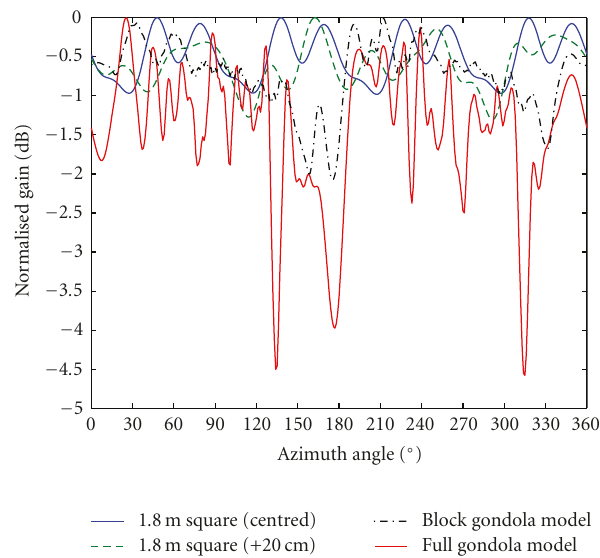
Figure 9: Variation of zenith angle 80 ◦ gain with azimuth angle of the single turn helical antenna on square 1.8m sided ground planes and gondola models, from